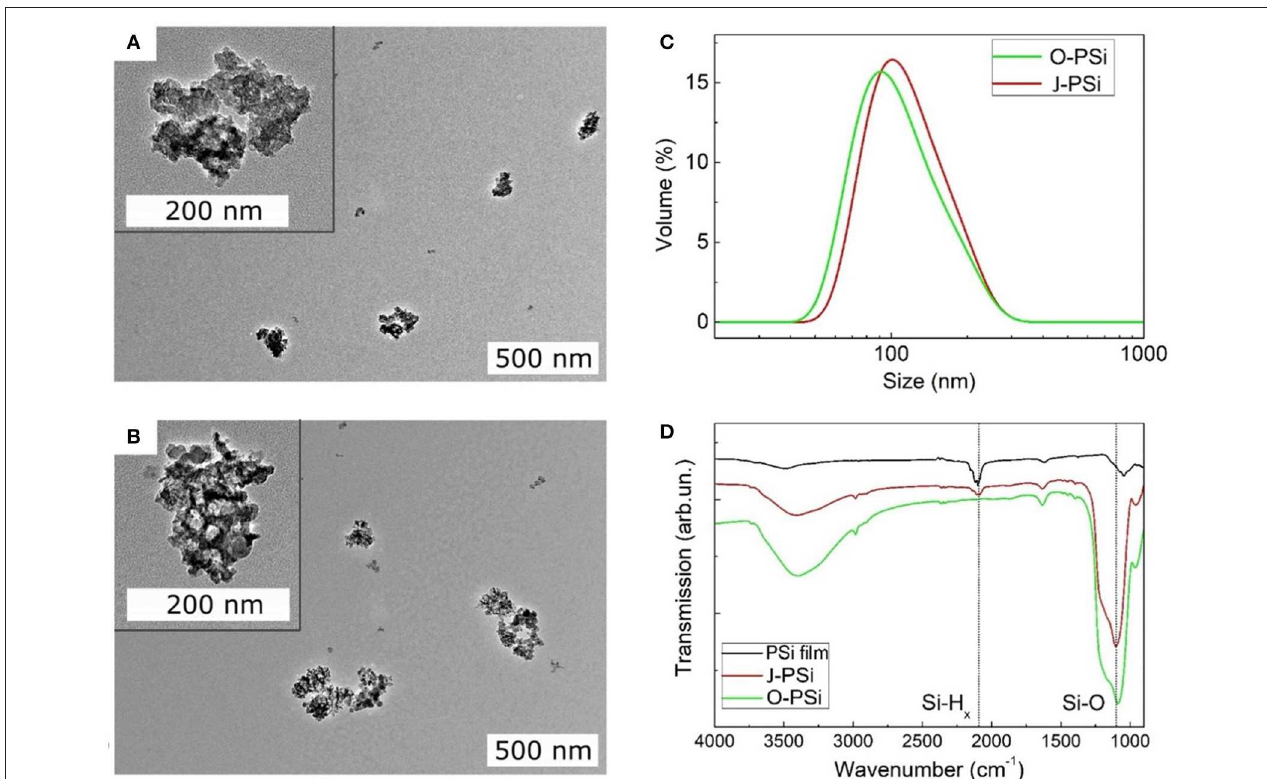
FIGURE 3 | Material characterization of the PSi NPs. (A,B) The TEM images of TO-PSi NPs and J-PSi NPs, respectively; the insets show the NPs at a smaller scale. (C) Hydrodynamic size distributions of O-PSi NPs (green line) and J-PSi NPs (red line) in water. (D) FTIR spectra of the hydrogen terminated pristine PSi NPs (black line), O-PSi NPs (green line), and J-PSi NPs (red line).